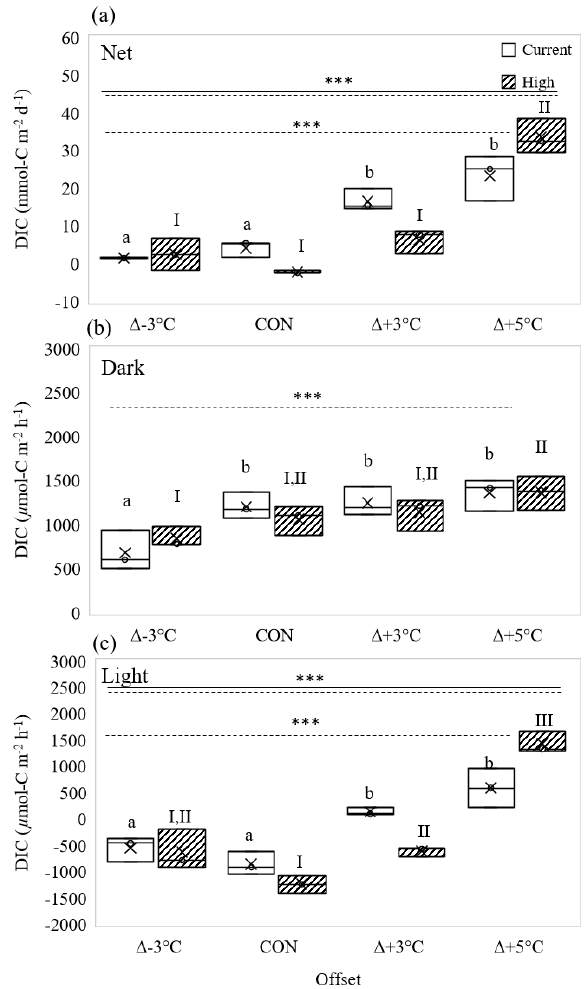
Figure 3. Effect of temperature on (a) net dissolved inorganic car- bon (DIC) production (mmolCm − 2 d − 1 ) , and (b) dark and (c) light DIC fluxes (µmolCm − 2 h − 1 ) under current (open boxes) and high- p CO 2 conditions (hatched boxes). Panels show mean values “ × ” at three temperature offsets from control conditions (CON = 23 ◦ C). Middle horizontal line in each box is the exclusive median, with the start of the upper and lower quartiles represented by the top and bot- tom edges of the box, respectively. Letters identify significantly dif- ferent means across temperatures under current p CO 2 conditions, and numerals identify significantly different means across temper- atures under high- p CO 2 conditions, where letters or numerals that are the same indicate no significant difference, as determined by a one-way ANOVA and post hoc Tukey’s test. Solid and dashed hor- izontal lines identify significant effects of OA and temperature, re- spectively, where double solid and dashed lines identify significant interaction of temperature and OA (two-way ANOVA). Levels of significance are denoted with “ ∗ ” for 0.05, “ ∗∗ ” for 0.01, and “ ∗∗∗ ” for 0.001. Data in Table